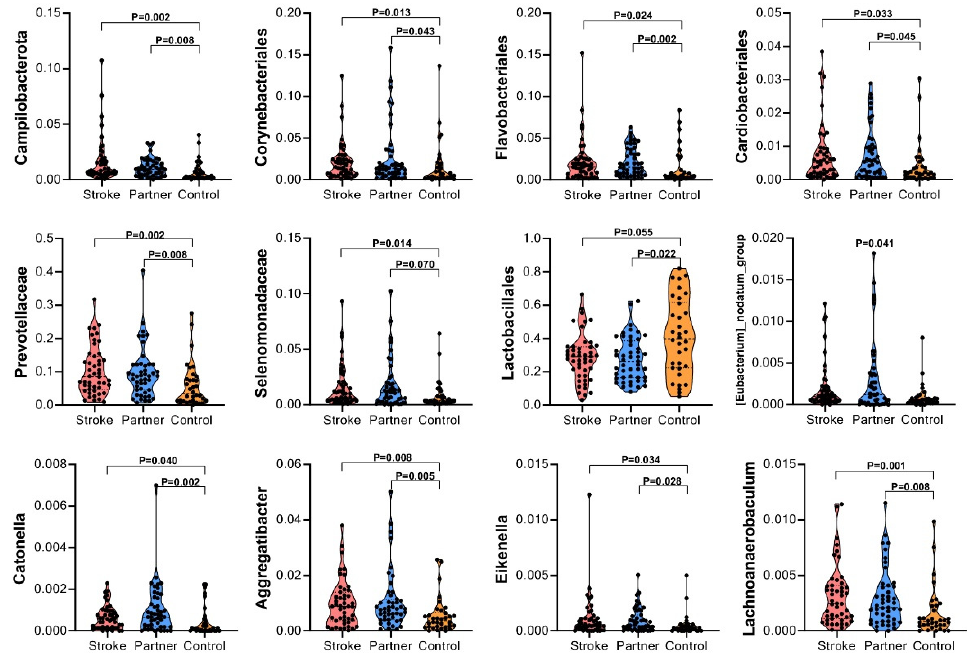
Figure 4. Comparison of several bacteria with different abundances among the three groups, i.e., Campilobacterota , Corynebateriales , Flavobateriales , Cardiobacteriales , Prevotellaceae , Selenomonadaceae , Lactobacillales , [Eubacterium]_nodatum _group, Catonella , Aggregatibacter , Eikenella, and Lachnoanaerobaculum , were calculated.